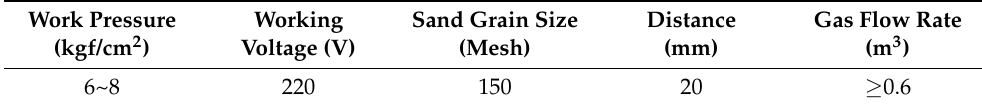
Table 3. Technological parameters of sandblasting.